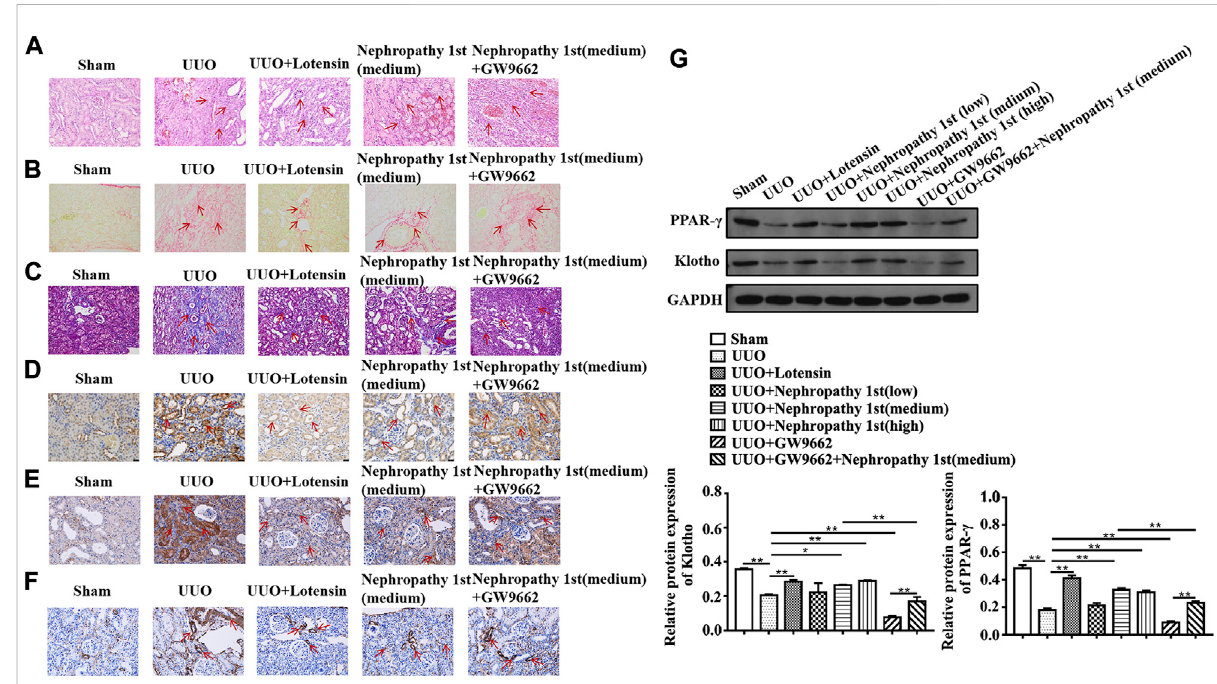
Nephropathy 1st attenuated rat renal fi brosis by activating the PPAR γ /Klotho pathway in vivo . (A) HE staining, (B) Sirius Red Staining, (C) Masson staining, (D – F) TGF- β 1, collagen III, and α -SMA IHC staining of different kidney tissues. (G) Expression of PPAR γ and Klotho in the UUO group and lotensin group. Nephropathy 1st group and GW9662 (PPAR γ inhibitor) group were analyzed by Western blot. ImageJ software was utilized for the measurement of the blot intensity of (G) . Data were representative of three independent experiments. *p < 0.05, **p < 0.01, and *p < 0.01 vs. control; ##p < 0.01 vs.